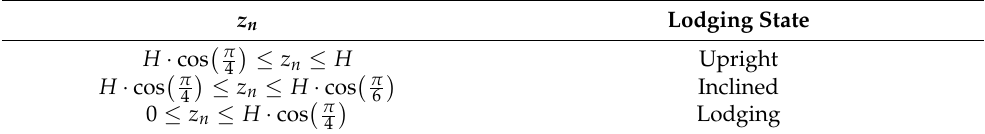
Table 2. Wheat lodging detection method.